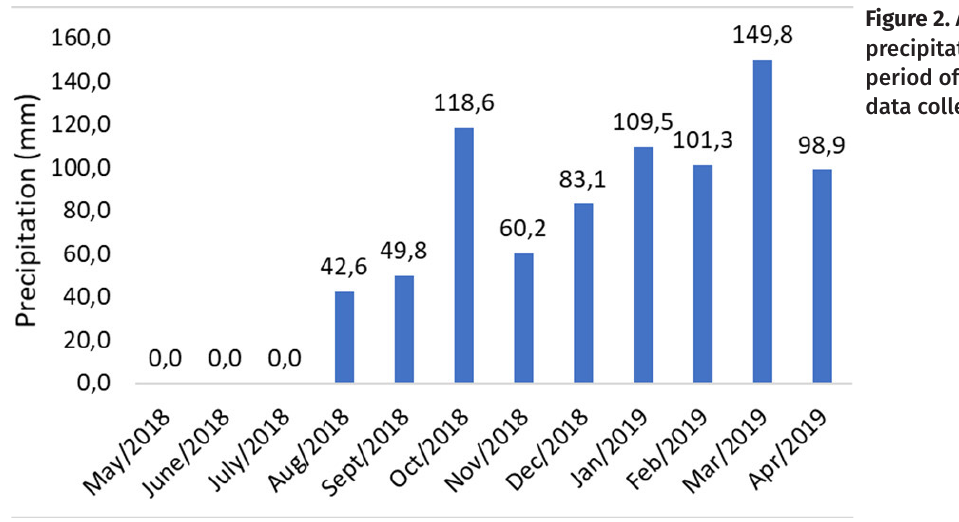
Figure 2. Accumulated precipitation for the period of 15 days before data